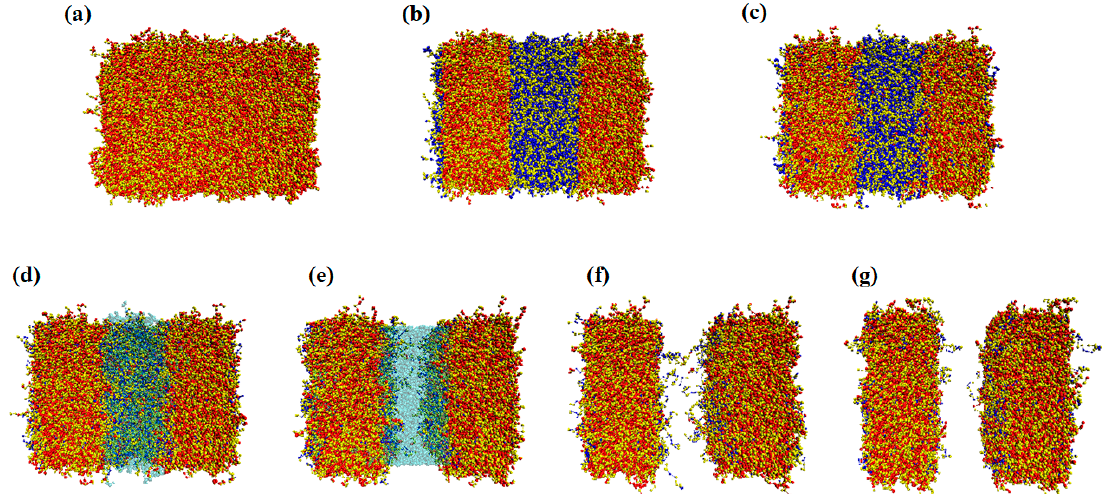
Figure 2. Top view images of the EUV chemically amplified resist (CAR) patterning process. Low T g , N = 64 and f p = 0.5, were simulated in this system; ( a ) spin coating, ( b ) exposure, ( c ) post-exposure bake (PEB), ( d ) beginning of the development, ( e ) during development, ( f ) immediately after the development, and ( g ) after drying the remaining developer. Images were generated by wrapping the simulation results in the x -direction, corresponding to the system size of 48 × 32 × 30 nm.